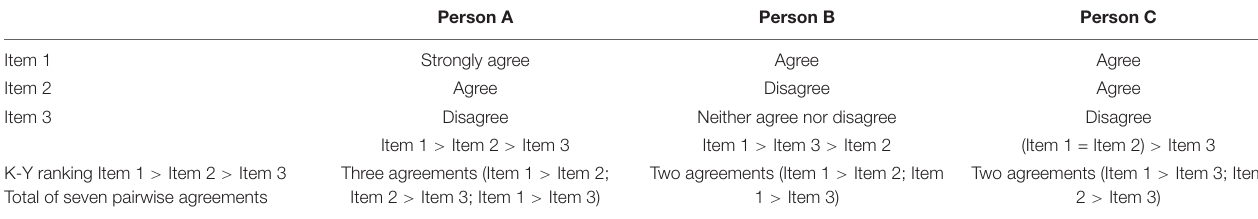
TABLE 1 | Synthesised responses to illustrate Kemeny-Young